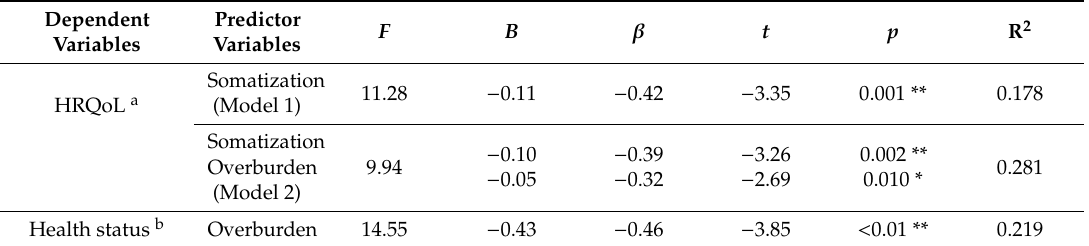
Summary of the stepwise regression analysis of health-related quality of life and associated